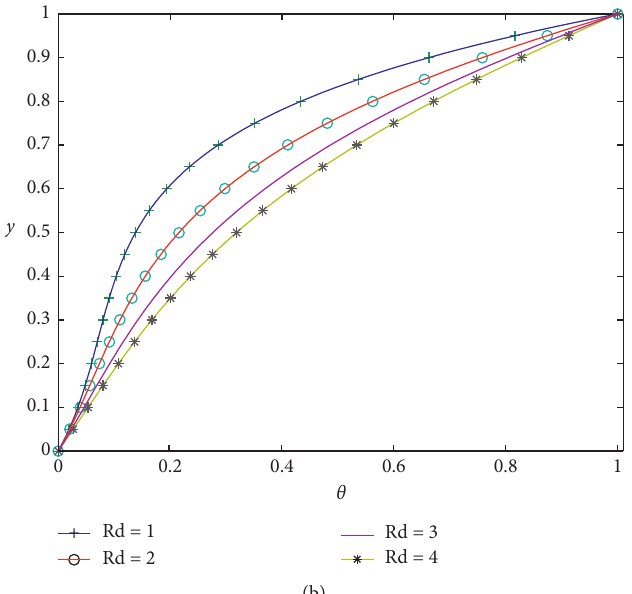
Figure 4: Temperature distribution for t � π /4 , ε � 0 . 01 ,H � 3 , β � 2 , Ec � 0 . 1 ,Q � 0 . 5 , Da � 0 . 1 ,M � 0 . 5 , Re � 1 , and ϕ � 0 . 1. (a) Effect of Pr when Rd � 2, and (b) effect of Rd when Pr � 21.